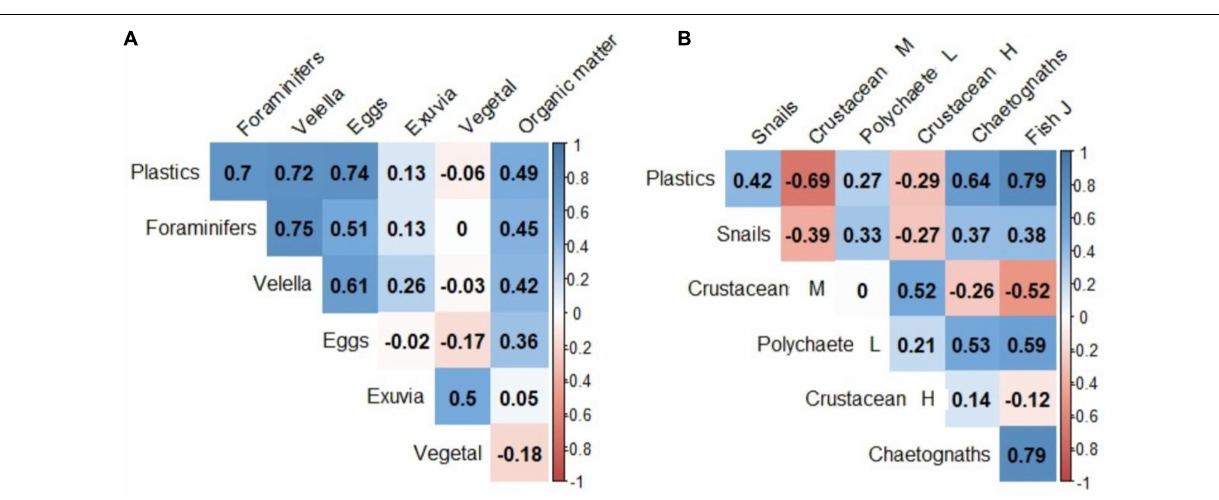
FIGURE 7 | The correlation matrix between (A) plastics and groups with no or moderate motility, and (B) plastics and groups with high motility. Positive correlations are blue and negative correlations are red, the color intensity is proportional to the significance of the Spearman correlations coefficients and the number inside the box corresponds to Spearman’s coefficient (i.e., the closer to –1 or 1). Crustacean M, crustaceans with moderate mobility; Crustacean H, crustaceans with high mobility; Polychaete L, polychaete larvae; Fish J, early developmental stages of fish. The order of the groups is given by the mobility index: crustaceans